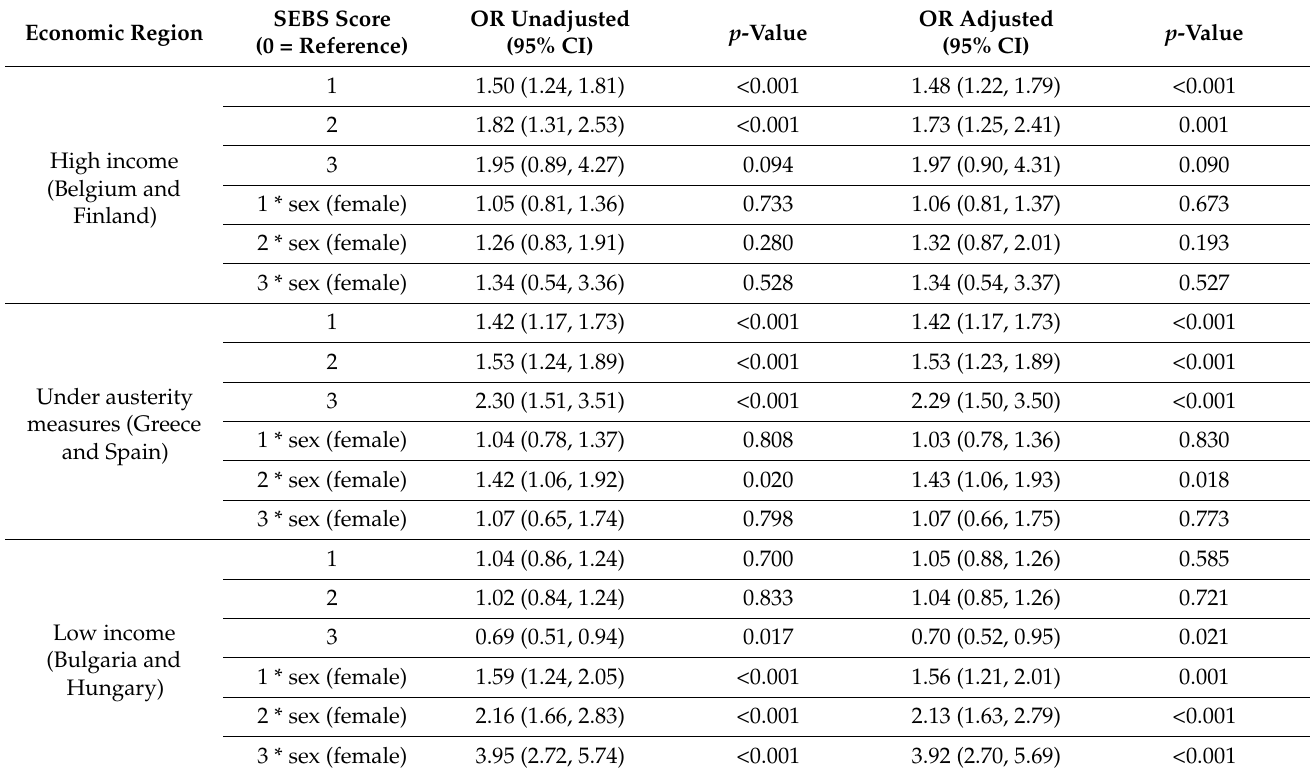
Table A2. SEBS score and the risk of being overweight or obese based on the country’s economic status. (Interaction term of sex * SEBS